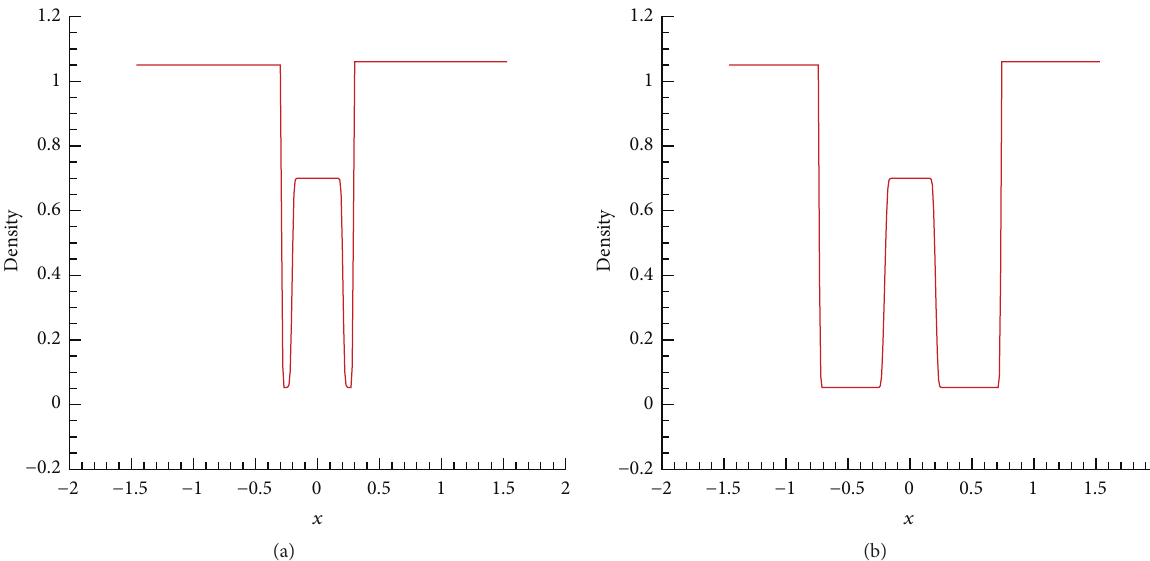
Figure 15: Numerical results of 𝜌 at 𝑡 = 0.8 (a) and 𝑡 = 5 (b) for Data 4.